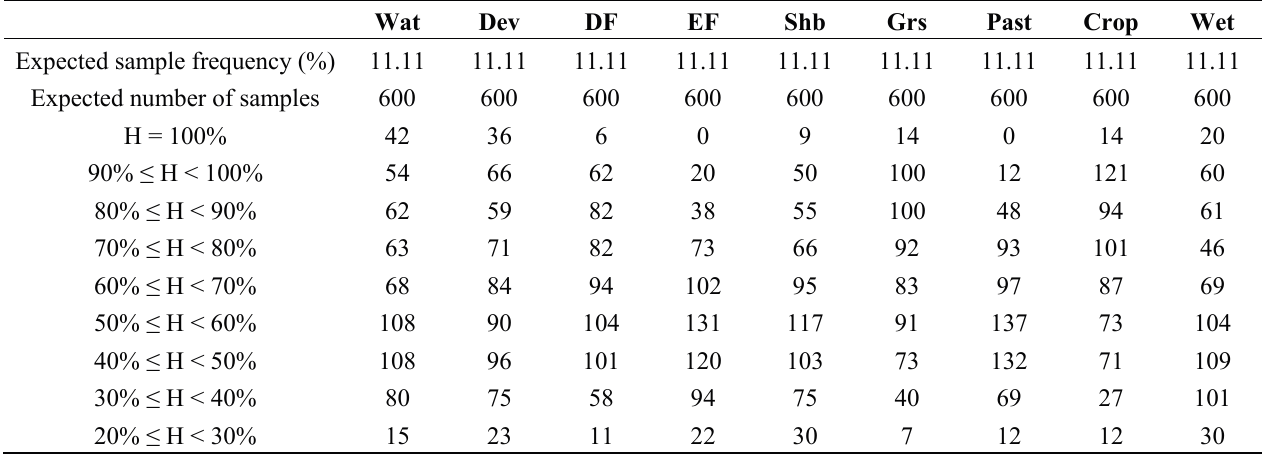
Table 6. Equal class allocation of heterogeneous pixels with random allocation across bins of argmax(H) . Homogeneity (H) in percent. See Table 1 for abbreviations of class